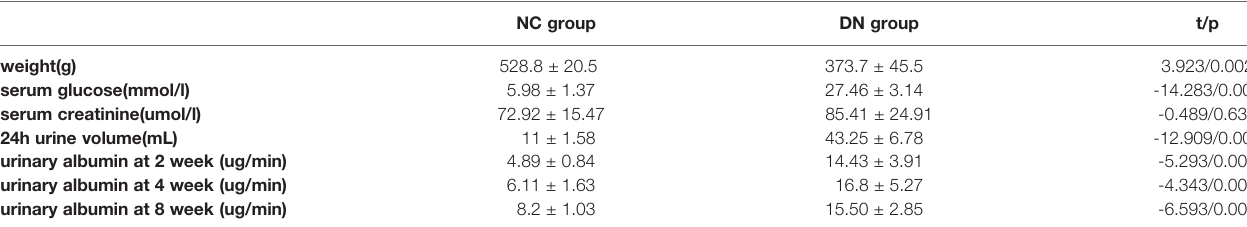
TABLE 1 | General condition and biochemistry (x ̄ ±